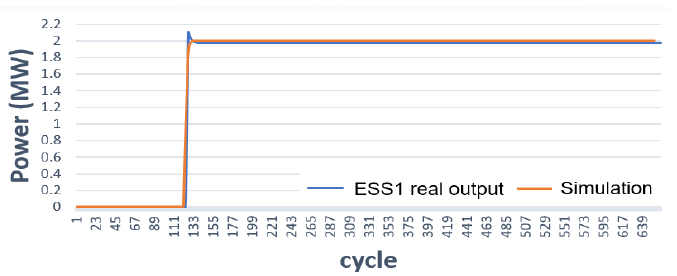
Figure 5. Output response of ESS1 to an N-1 contingency from PSSE and as measured from phasor measurement Unit (PMU).